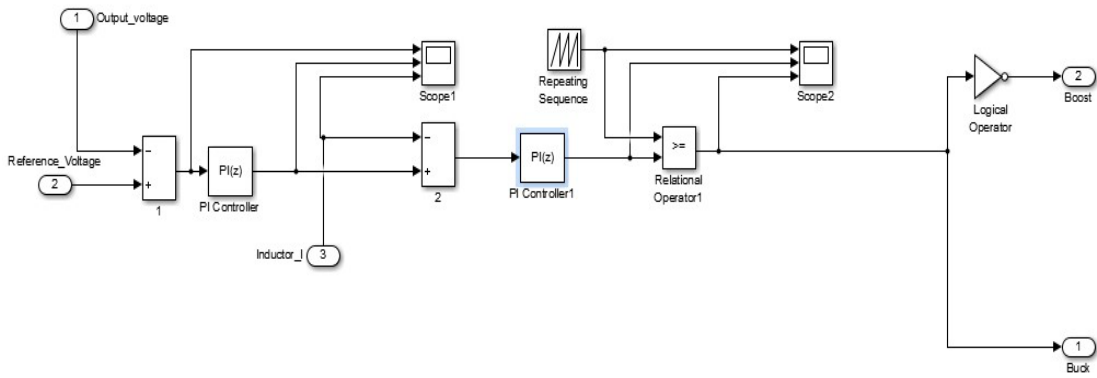
Figure 13. Bidirectional buck-boost converter controller in Simulink.